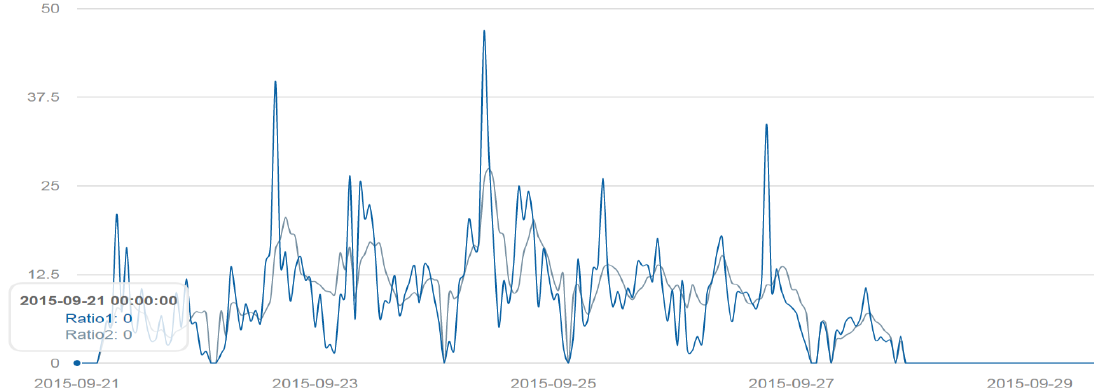
Figure 9. Temporal spectrum of the Pope Visit related tweets between 21–29 September.